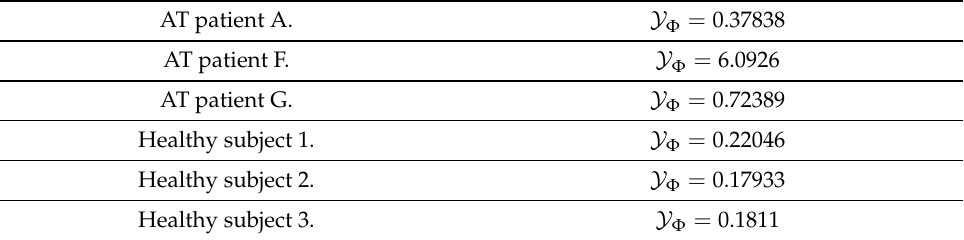
Table 7. The values of the computed Φ -bonacci gait number in (6) (all the gains within it are set equal to 1). AT patient A. Y Φ = 0.37838 AT patient F. Y Φ =